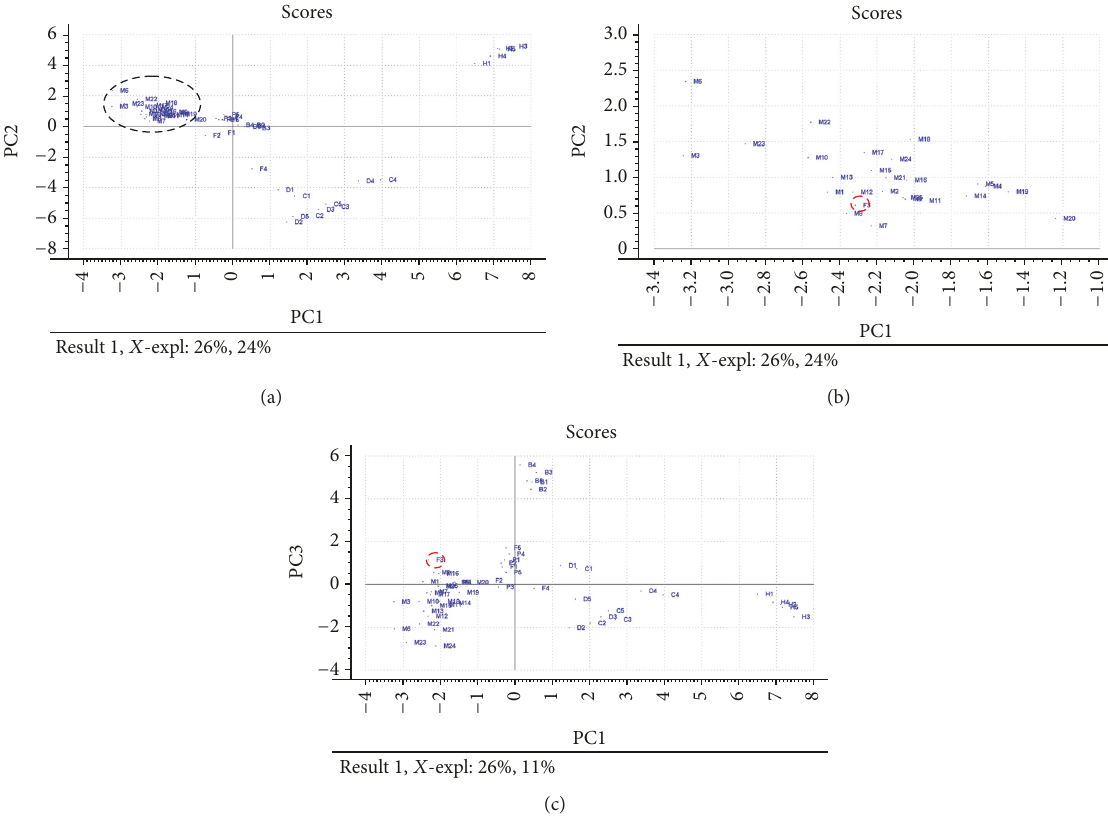
Figure 1: Principal component projections for the 25 mutton samples (M1–M25), 5 fraud samples (F 1 : pork mixed with synthetic simulated mutton flavor; F 2 : duck mixed with synthetic simulated mutton flavor; F 3 : pork lean mixed with mutton fat; F 4 : duck mixed with 20% lean mutton; F 5 : pork mixed with 20% lean mutton), and 25 other kinds of meat samples (D1–D5: duck samples; C1–C5: Chicken samples; H1–H5: horsemeat samples; B1-B5: beef samples; P1-P5: pork samples). (a) PC1-PC2; (b) enlargement of the dashed line and spot line in figure (a); (c)